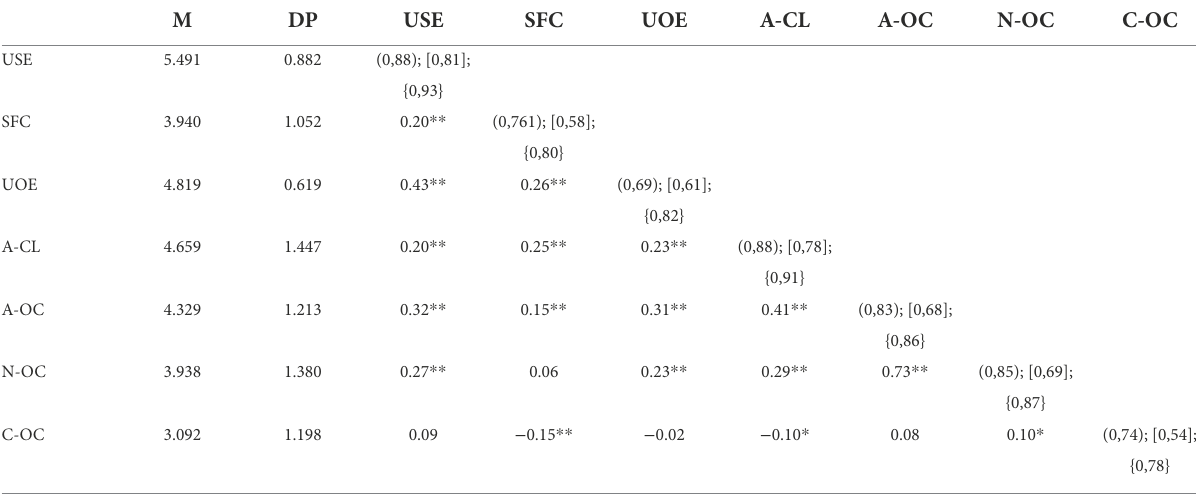
TABLE 1 Correlations between latent variables.